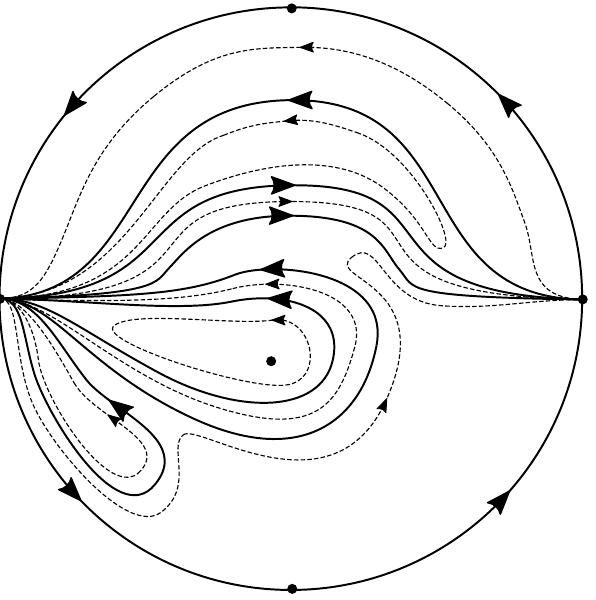
Figure 1 - The qualitative global phase portrait of system (1) in the Poincaré